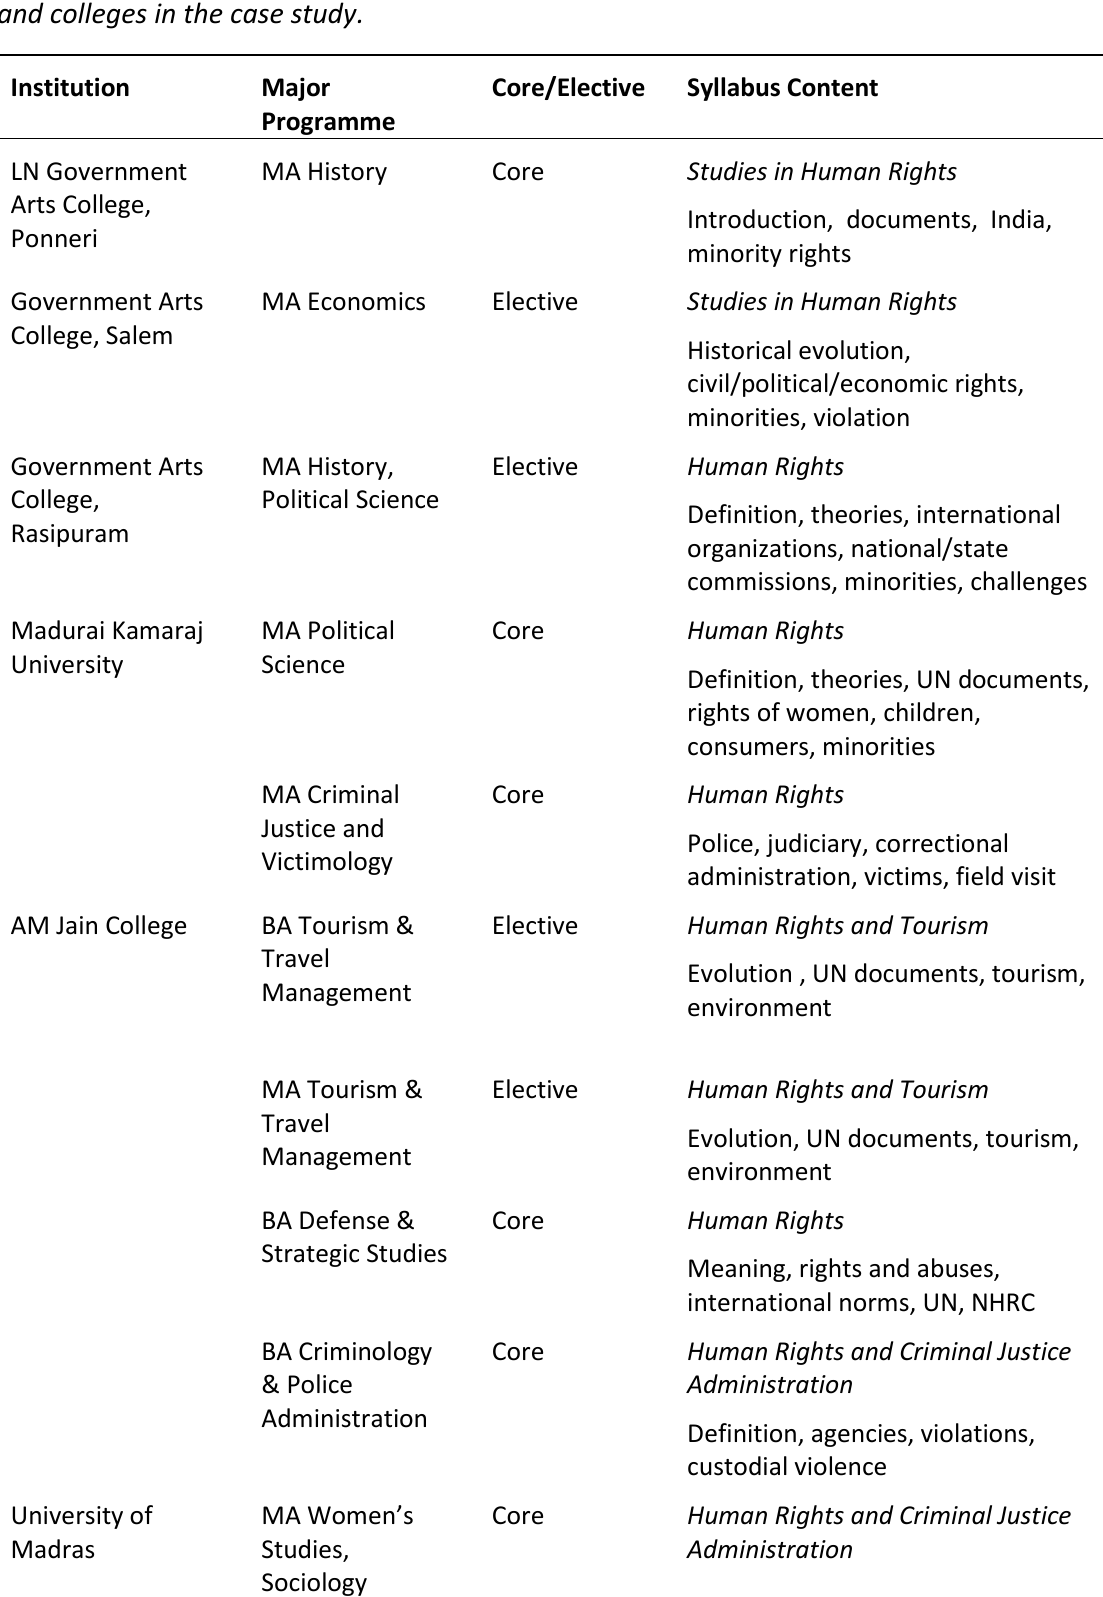
Elective and Core Human Rights Courses in TN. Adapted from syllabi collected from universities and colleges in the case